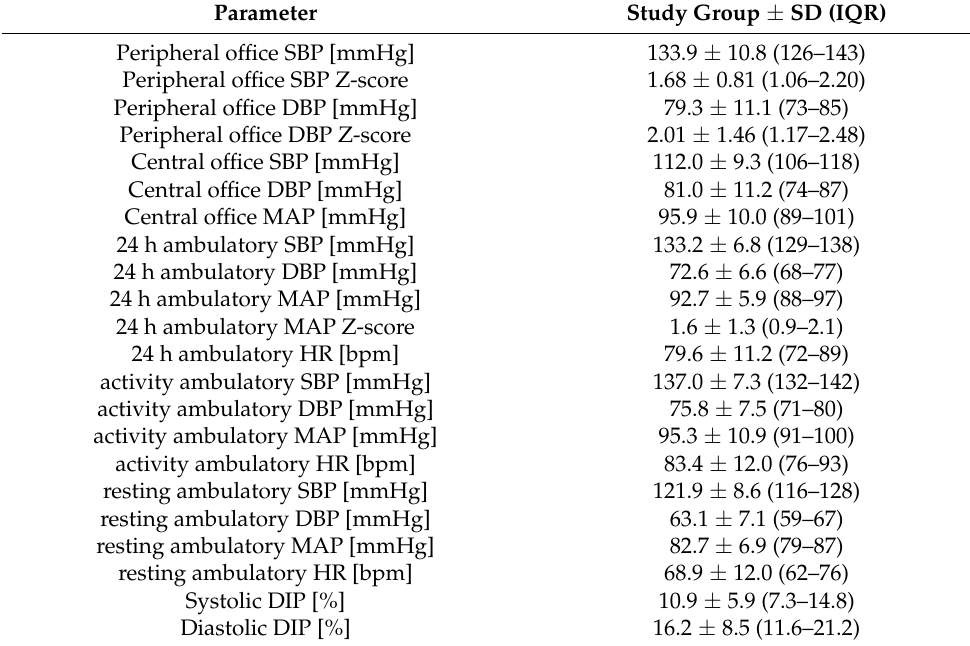
Table 3. Office peripheral, office central, and peripheral ambulatory blood pressure.